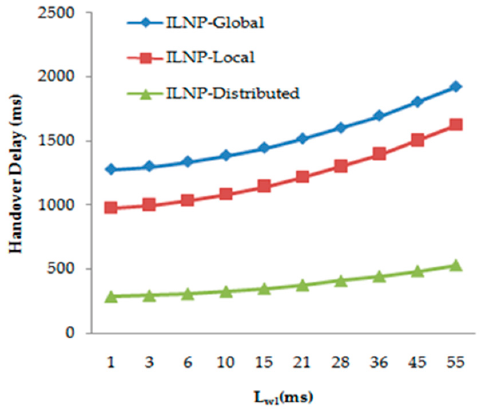
Figure 24. Impact of L wl on HOD.